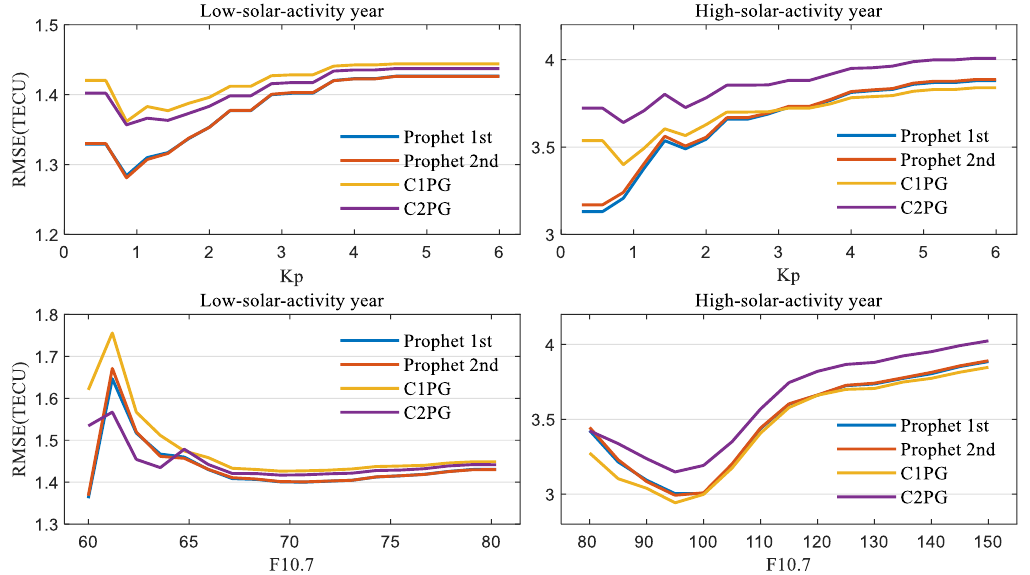
Figure 16. RMSE for variation with Kp index and F10.7 index. Blue and red lines represent the Prophet model. Yellow and purple lines represent the COPG value.